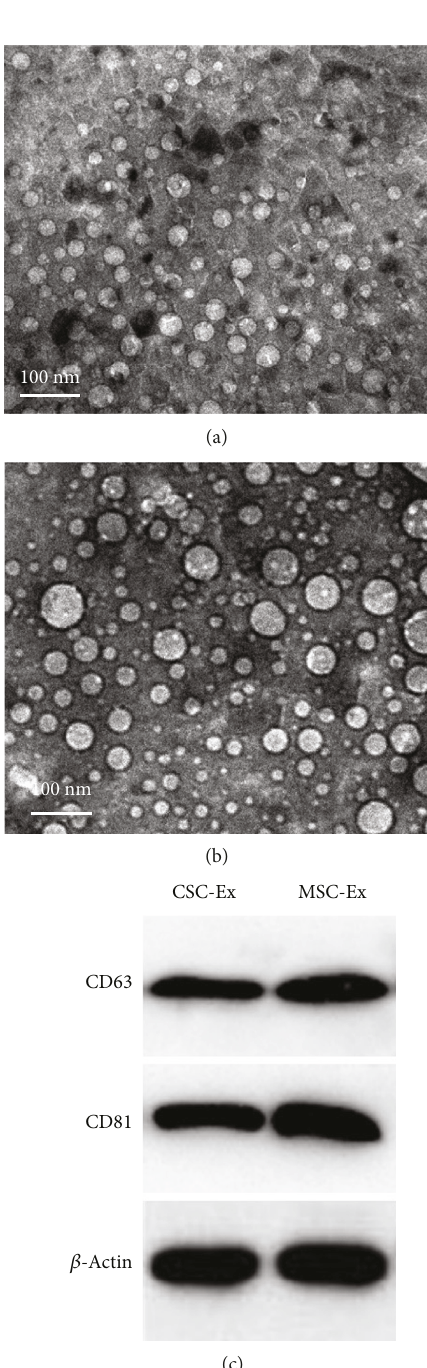
Figure 2: Characterization and labeling of CSC- and MSC-derived exosomes. Transmission electron microscopic examination shows small nanovesicles (30 – 100 nm) in the sample isolated from the BM-MSCs (a) and hepatic CSCs (b) culture media by ultracentrifugation. Western blot analysis of the culture medium, and exosomes shows presence of CD63 and CD81 in the exosomes of CSC-Ex and MSCs-Ex groups (c). β -Actin was used as internal loading